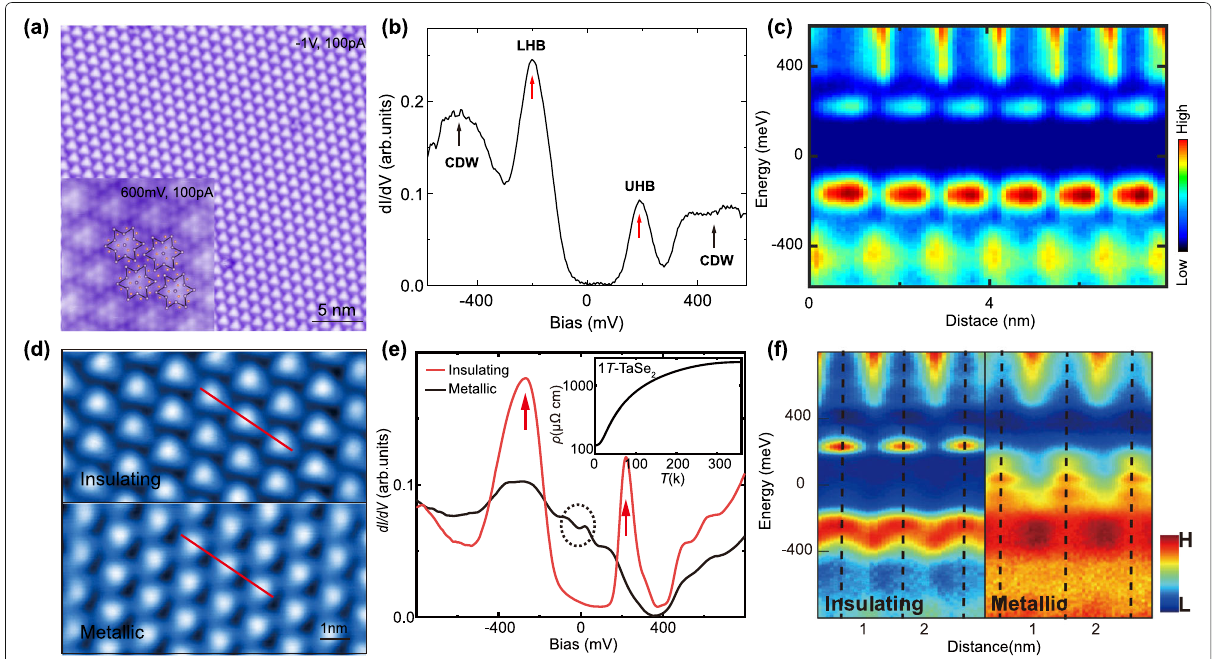
Fig. 2 Structural and electronic properties of bulk a – c 1 T -TaS 2 and d – f 1 T -TaSe 2 . a , d Typical topographies of 1 T -TaS 2 and 1 T -TaSe 2 , respectively. b , e Typical dI / dV spectra in a and d . c , f The dI / dV line-cut maps of 1 T -TaS 2 and 1 T -TaSe 2 , respectively. Left (right) panel in f shows the periodic evolution of spectrum on the insulating (metallic) surface. Taken from ref. [58, 59]